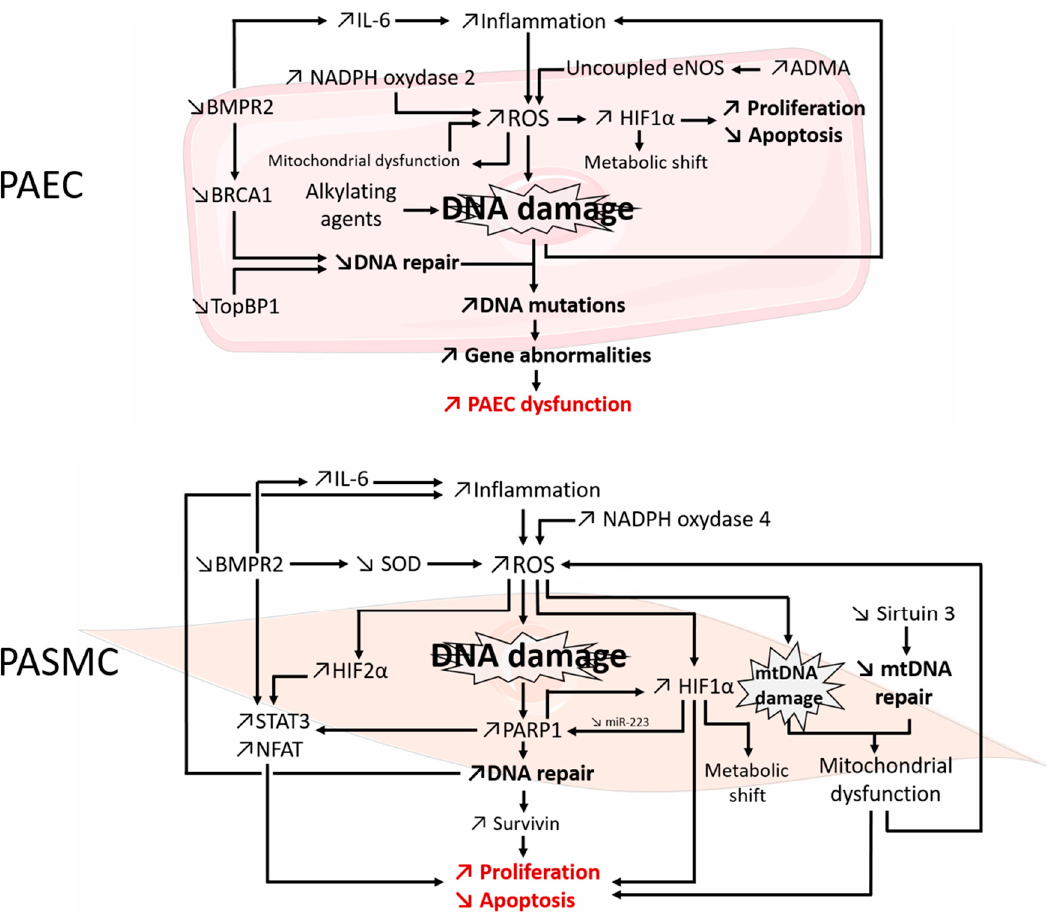
Figure 1. DNA damage and DNA-damage response mechanisms directly or indirectly involved in PAH pathogenesis via PAEC dysfunction and PASMC proliferation and apoptosis resistance (red). PAEC: pulmonary artery endothelial cell; PASMC: pulmonary artery smooth muscle cell; : ↗ upregulation; : downre ↘ gulation.